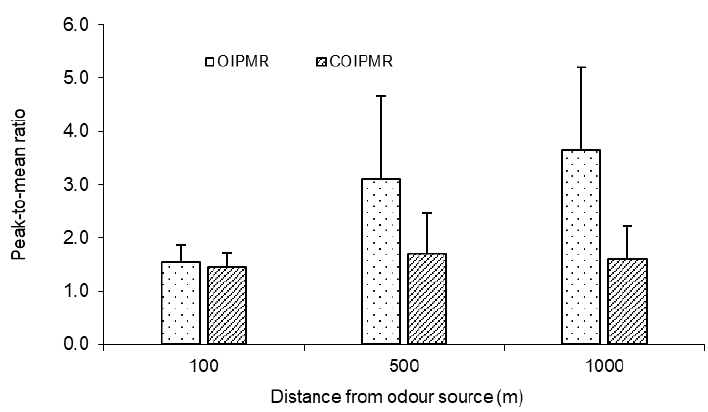
Figure 7. Comparison of measured PMR_OI (peak-to-mean ratio of odour intensity) and CPMR_OI (conditioned peak-to-mean ratio of odour intensity) (30 min averaging time) along the wind direction at 100, 500, and 1000 m from odour source (bar: standard deviation).